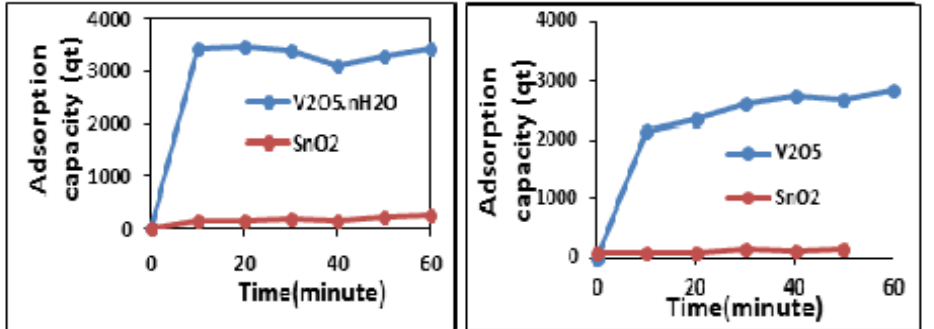
Figure (9): Adsorption capacity (q t ) of BTB onto V 2 O 5 .nH 2 O and SnO 2 nanoparticles heating at 90 o C and 500 o C for 60 min.